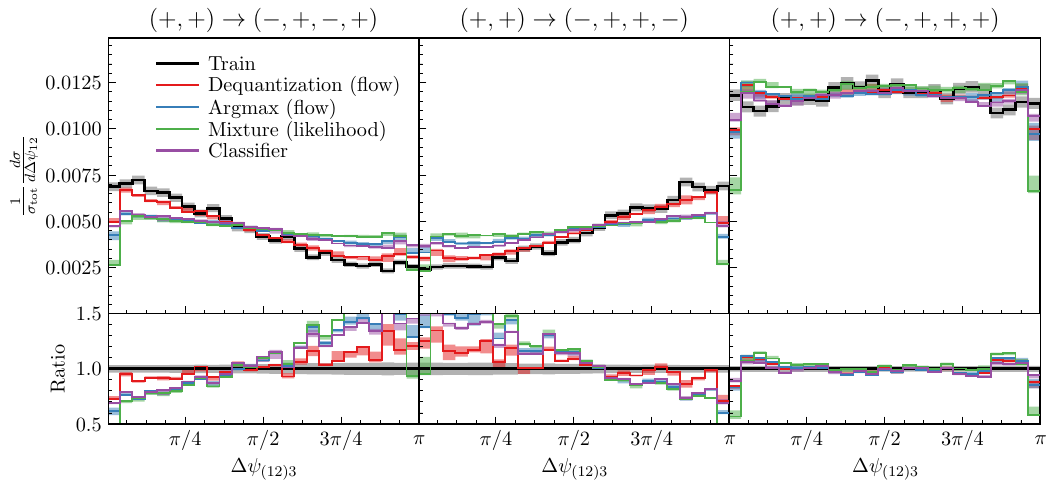
Figure 14: The distribution of the ∆ ψ ( observable defined in the text of a selection 12 ) 3 of helicity configurations as predicted by the same models as in figure